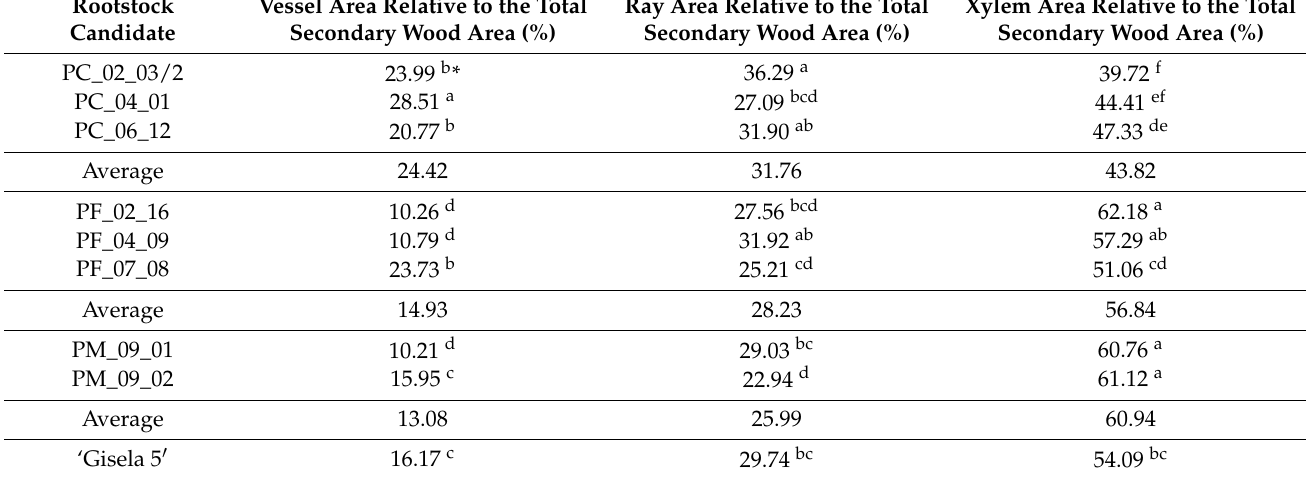
Table 2. Vessel, ray, and xylem areas relative to the total root secondary wood area, in the investigated cherry rootstocks, belonging to Prunus cerasus (PC), Prunus fruticosa (PF), Prunus mahaleb (PM), species and control ‘Gisela 5 (cid:48)